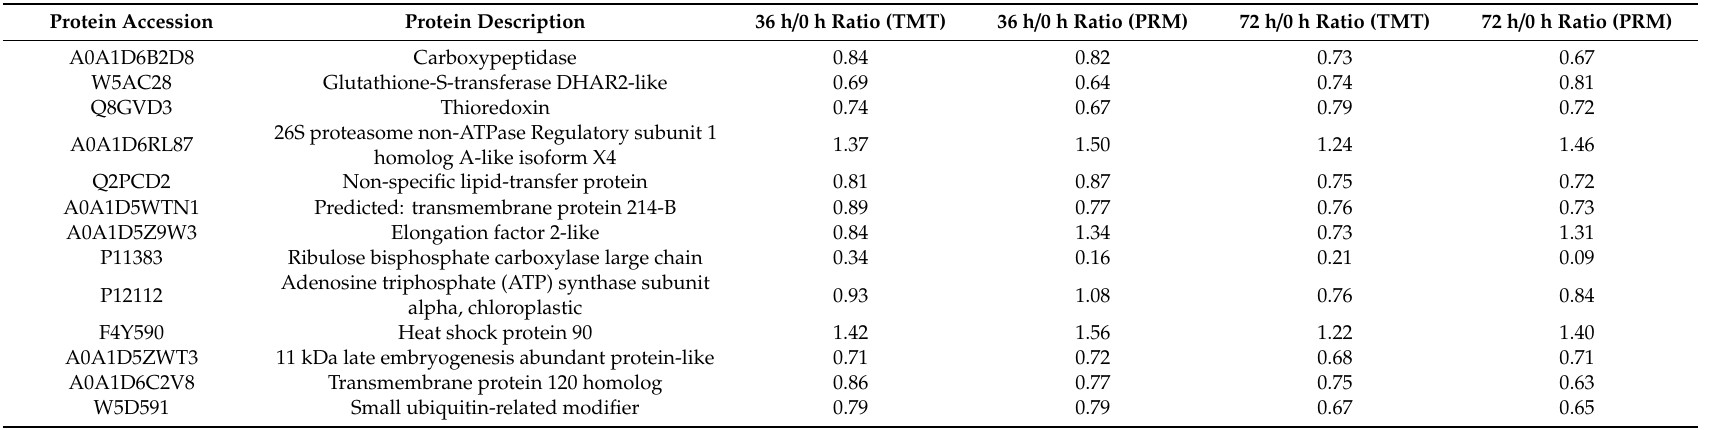
Table 2. Comparison between the isobaric tandem mass tag (TMT) labeling for relative quantitation and parallel reaction monitoring (PRM). Protein